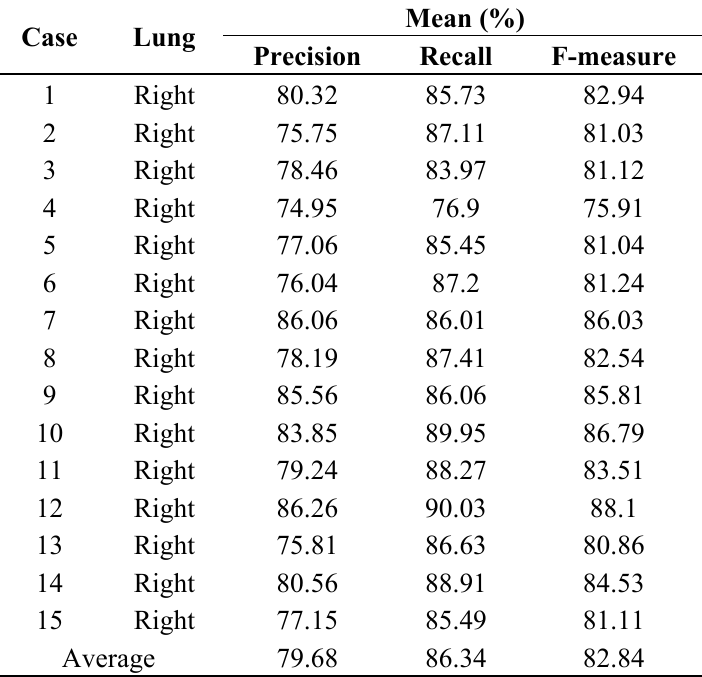
Table 3. The experimental results of precision, recall and F-measure by the proposed ACO method for 15 right lung